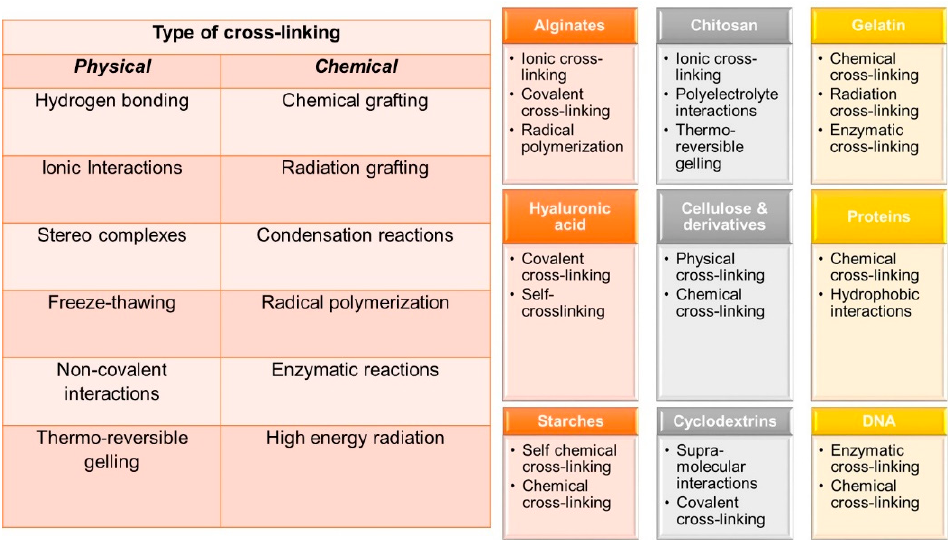
Figure 3. Typical hydrogel forming interactions and cross-linking pathways. The figure also displays widely used hydrogel-forming reactions of natural polymers including DNA.